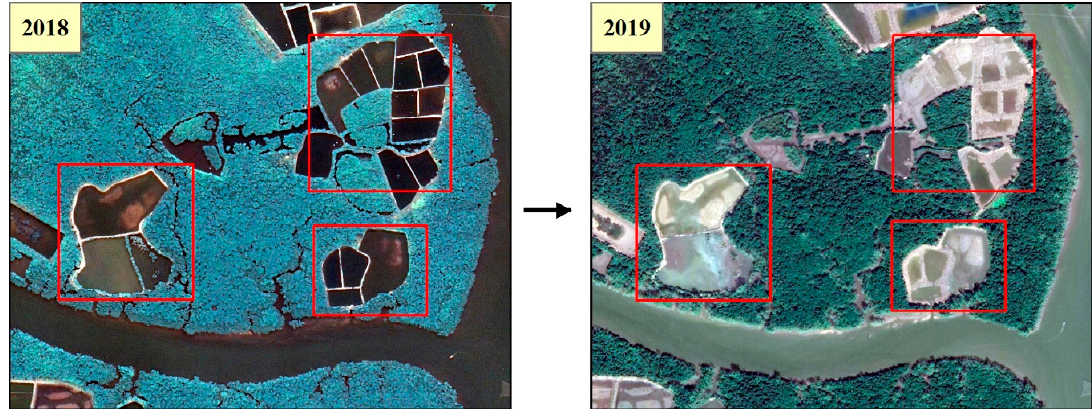
Figure 9. An illustration of the reforestation plan on Hainan Island: shrimp ponds were converted to mudflats and finally to mangrove forests. This happened in the Qinglan Harbor. The images are from Google Earth.